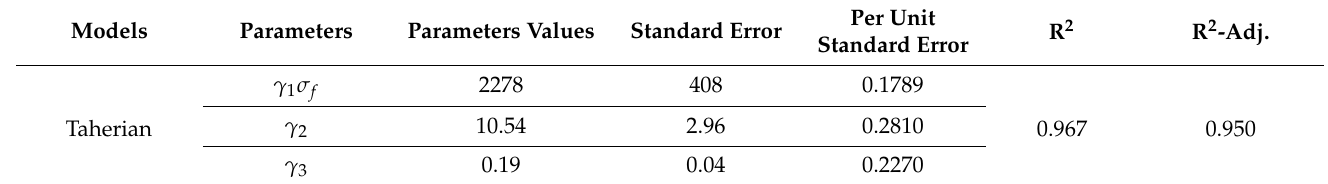
Table 3. Modified Taherian predictive model (MTM)